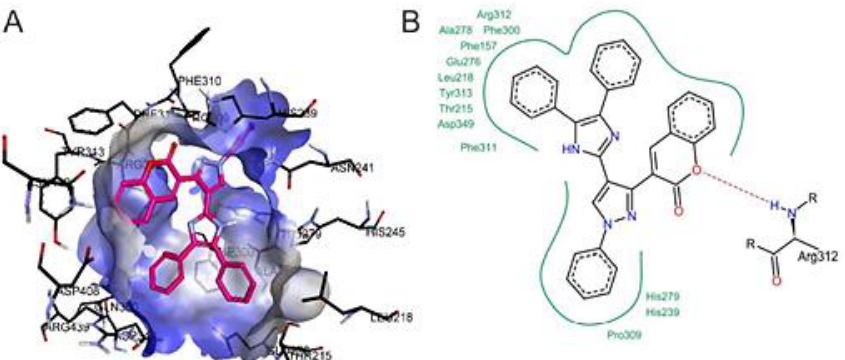
Figure 10. ( A ) Overall structure of the oligo-1,6-glucosidase (PDB ID: 3A4A) from Saccharomyces cerevisiae with compound 144j , and ( B ) 2D interactions for compound 144j . Image adapted from Chaudhry et al. [137].